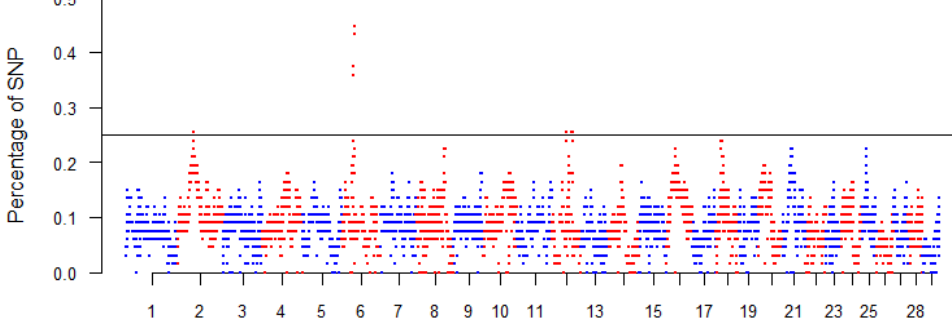
Figure 2. Manhattan plot of the incidence of each SNP in the runs of homozygosity in Mascaruna goat. A threshold of 0.25 was chosen to detect the islands.